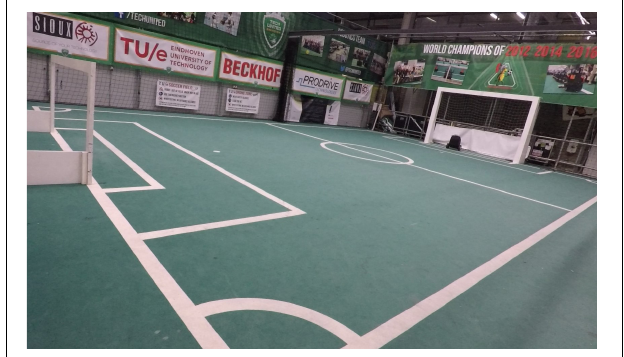
FIGURE 1 | The field on which the task was executed. Participants moved from the goal on the left to the goal on the right (where the robot is stationed).